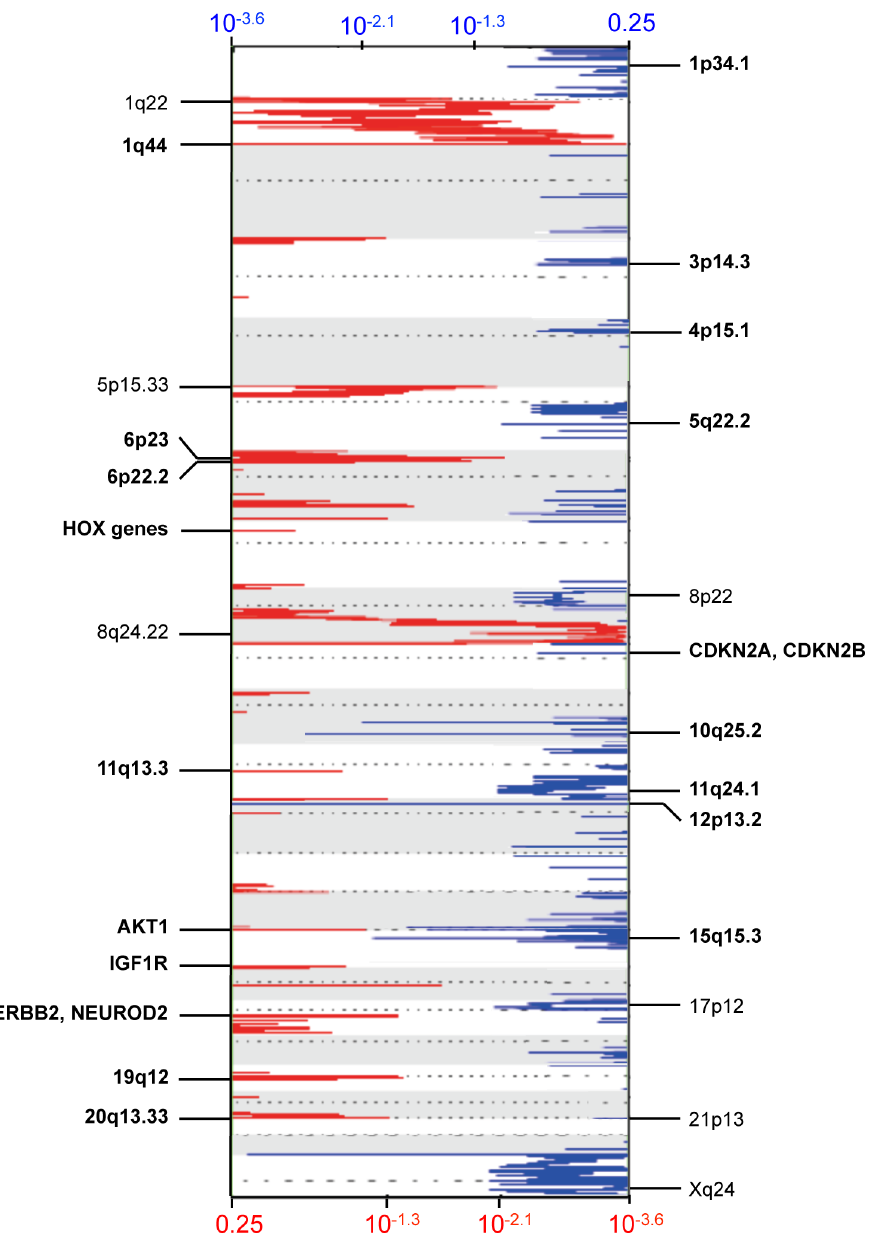
Figure 1. DNA Copy Number Analysis of Breast Brain Metastasis. GISTIC analysis was conducted on Agilent SurePrint G3 Human CGH Microarray data for 15 breast brain metastases. Significant false discovery rates (Q-values) for amplified (red) and deleted (blue) regions are plotted genome-wide. Annotations for a few of the significant regions are shown. Focal amplifications and deletions are annotated in boldface, and broad amplifications and deletions are annotated in non-boldface. Q-values for deleted and amplified genes are displayed along the x-axis on top and bottom of the figure, respectively.